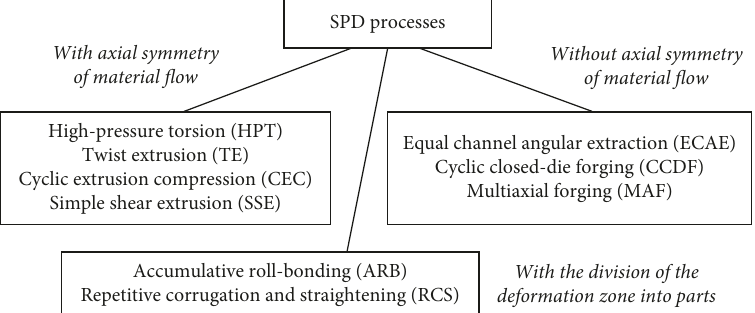
Figure 1: Division of SPD processes into groups.